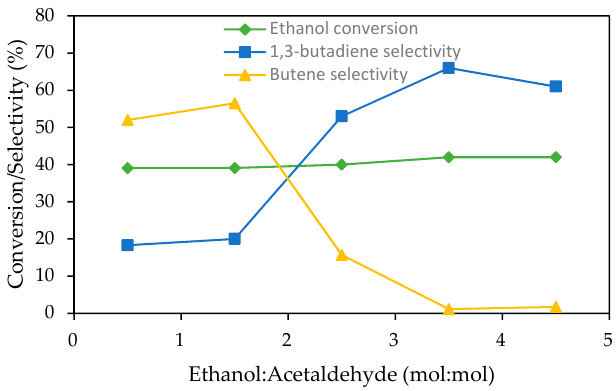
Figure 12. Effect of ethanol/acetaldehyde ratio in the feed over 2% Zr/SiO 2 ( T = 593 K, WHSV = 1.2 h − 1 ). Reprinted with permission from [35]. Copyright 2015, Royal Society of Chemistry.